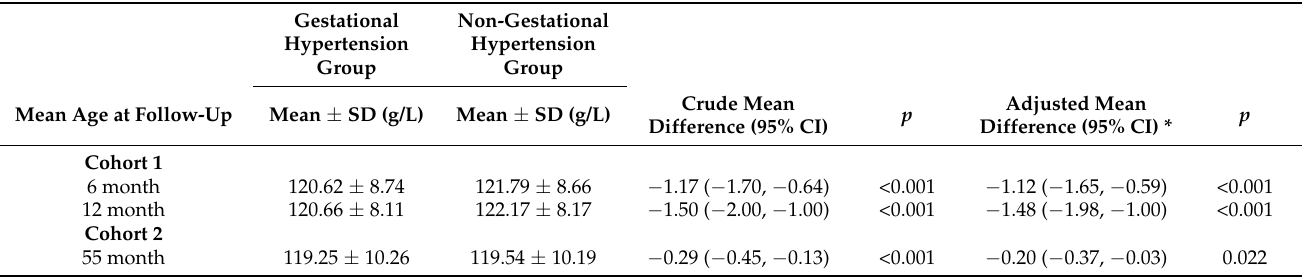
Table 3. Crude and adjusted mean difference in hemoglobin (g/L) for gestational hypertension group compared with non-gestational